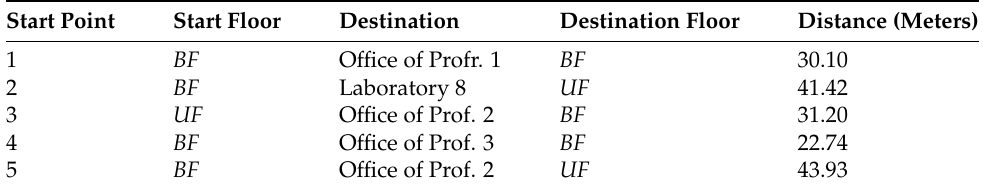
Figure 11. Scenario and navigation tasks for the Cinvestav building. Table 4. Navigation tasks for Cinvestav’s building: BF denotes Bottom Floor, and UF denotes Upper